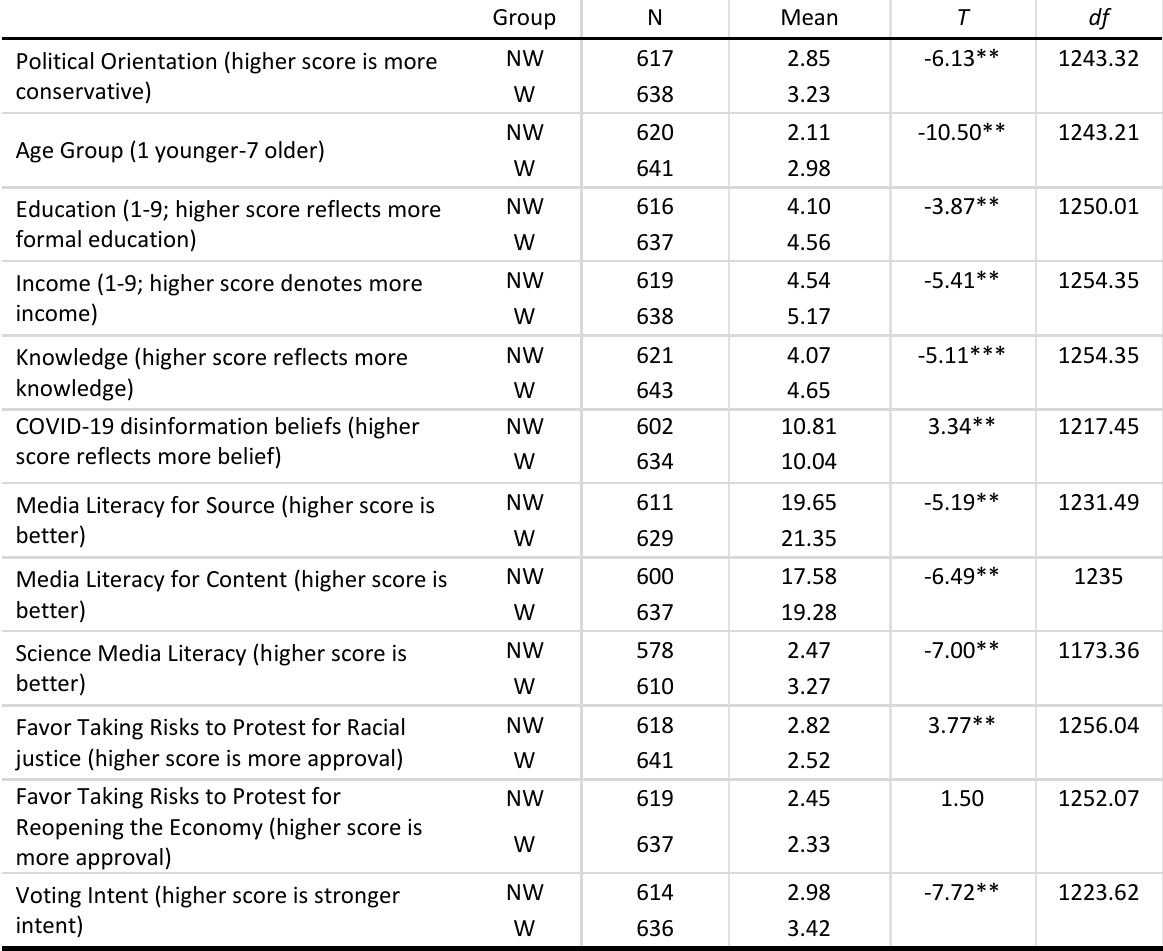
Table 1. t-tests comparing mean scores of white and nonwhite participants for key